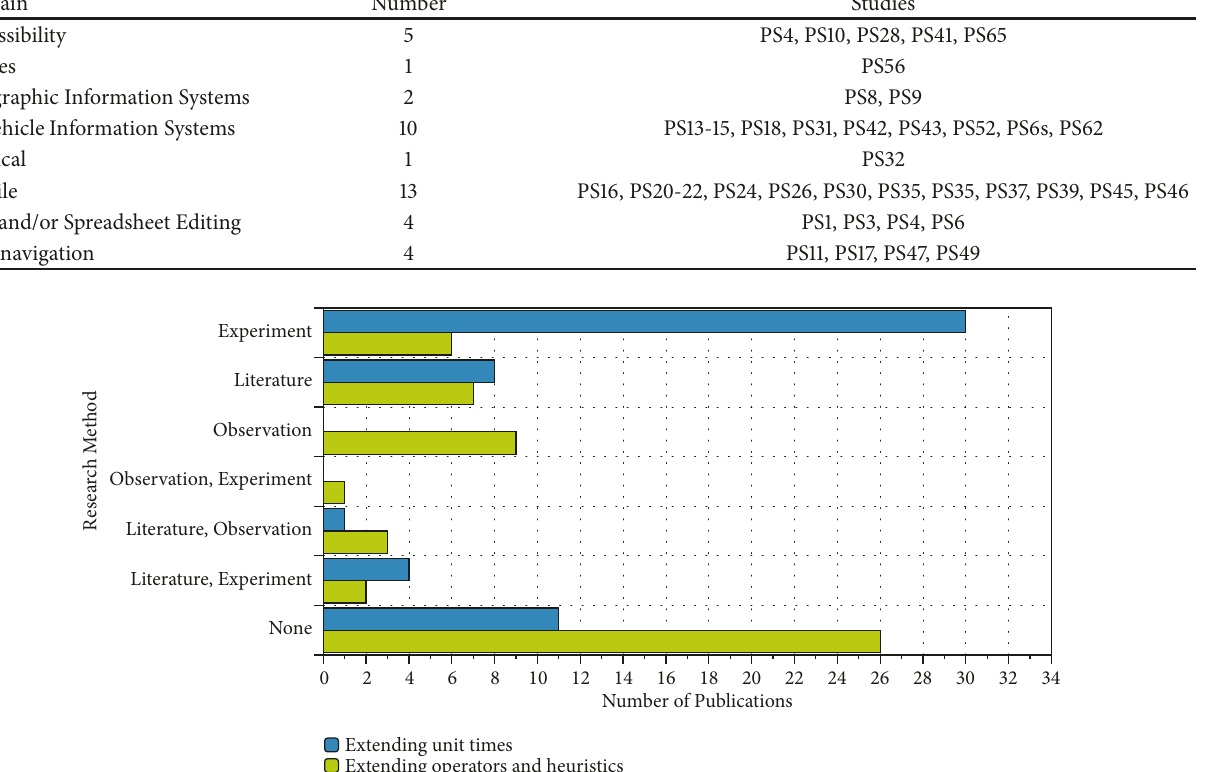
Figure 6: Research methods utilised to extend the KLM operators, heuristics, and unit times